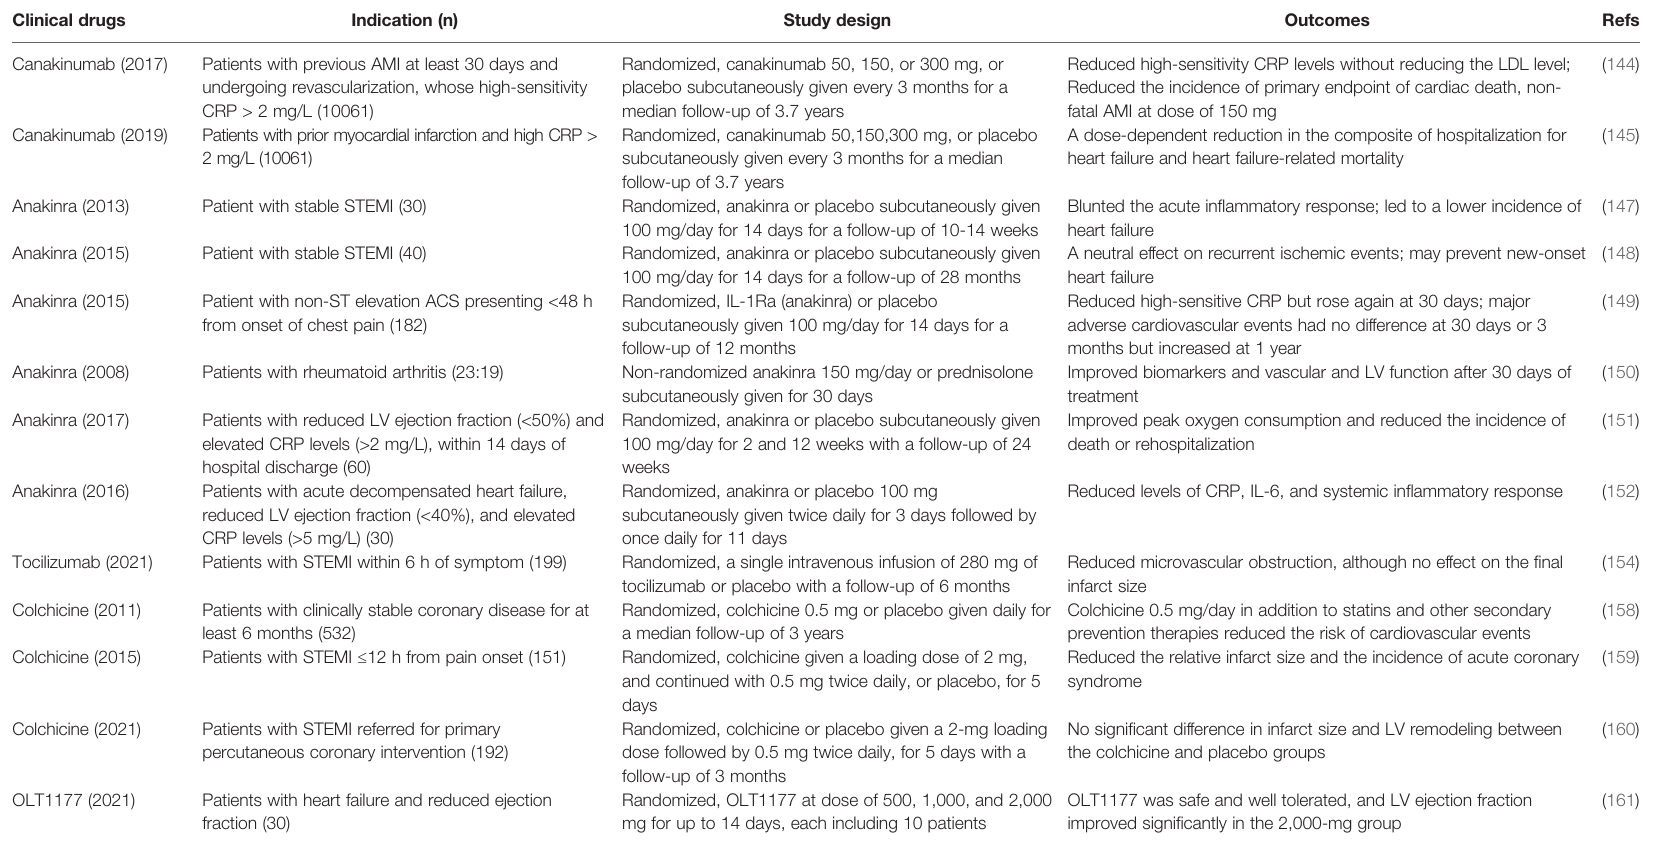
TABLE 3 | Clinical trials of NLRP3 in fl ammasome and IL-1 or IL-6 blockers in